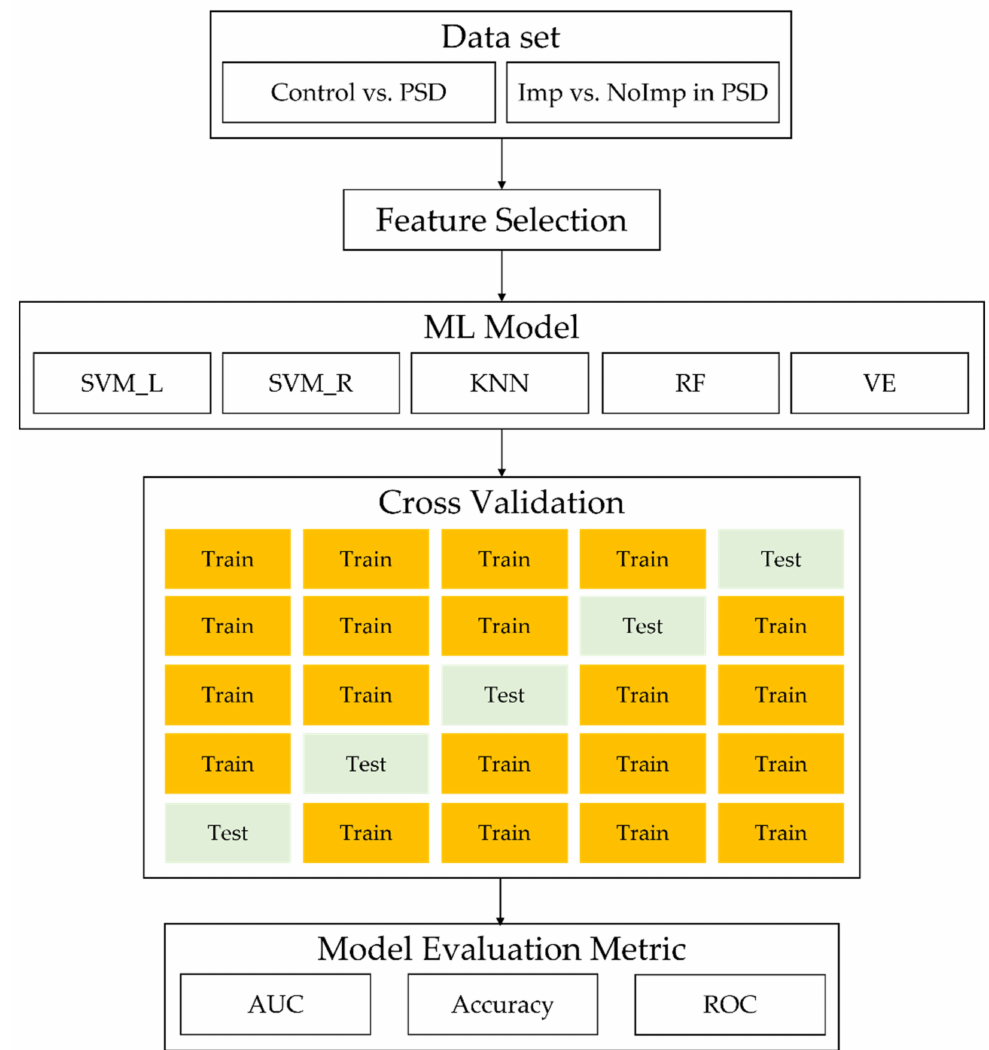
Figure 2. Flow of ML analysis. Abbreviations: PSD = poststroke depression; Imp = patients showing improvement in PSD symptoms; NoImp = patients showing no improvement in PSD symptoms; SVM_L = linear support vector machine; SVM_R = support vector machine with radial basis function kernel; KNN = k-nearest neighbors; RF = random forest; VE = voting ensemble; AUC = area under the curve; ROC = receiver operating